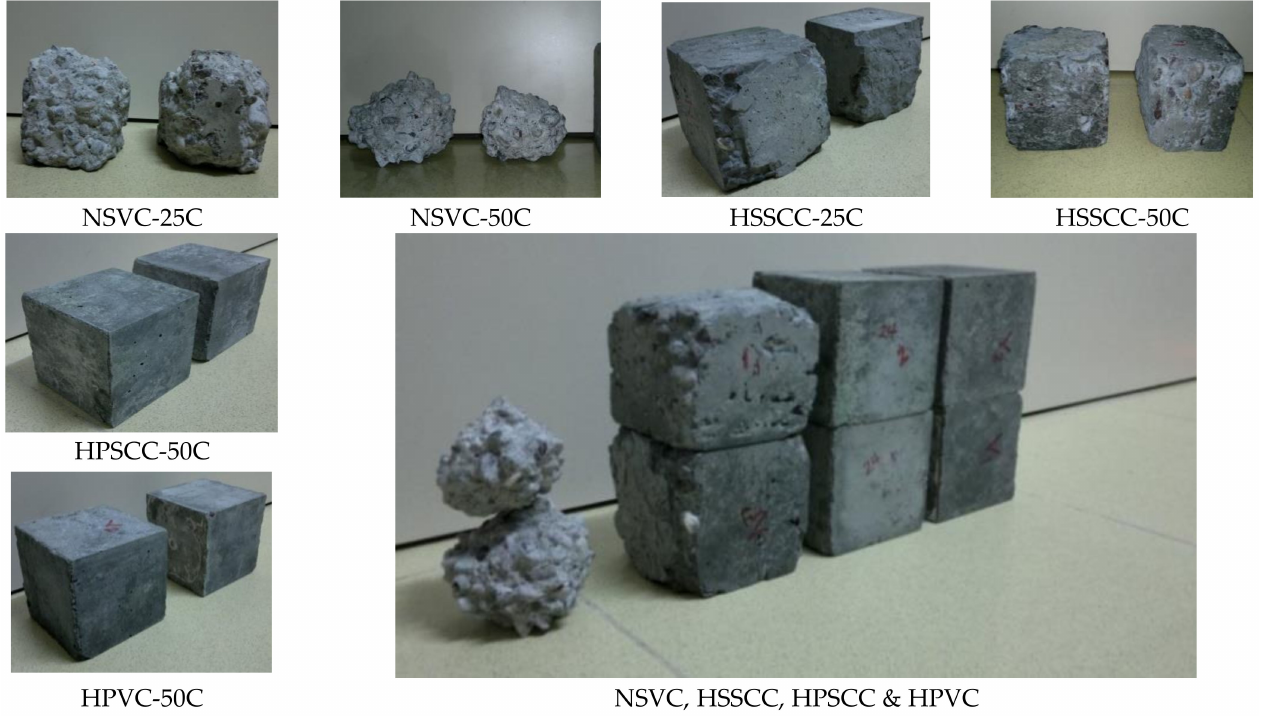
Figure 7. Freeze-thaw specimens after 25 and 50 cycles for NSVC and HSSCC and 50 cycles for HPSCC and